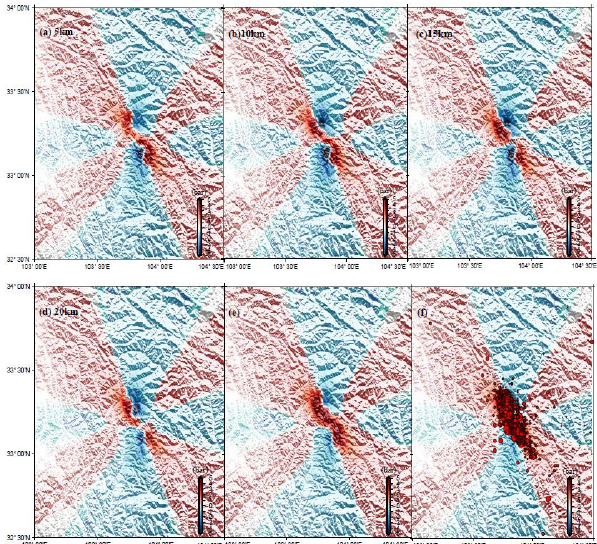
Figure 5. Map views of Coulomb stress change of Jiuzhaigou 7.0 earthquake and aftershocks distribution. (a) Coulomb stress change calculated at 5 km depth; (b) Coulomb stress change calculated at 10 km depth; (c) Coulomb stress change calculated at 15 km depth; (d) Coulomb stress change calculated at 20 km depth; (e) The maximum calculated Coulomb stress change between 5 km-20 km depth; (d) Calculated Coulomb stress change with aftershocks distribution. Table. 2 Simulating strong motion parameters for